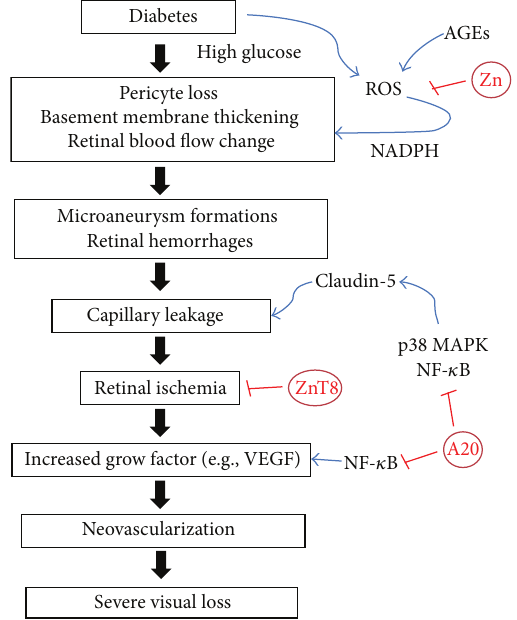
Figure 2: Proposed mechanism by which zinc protects from DR. Zinc protects DR by suppressing the pericyte apoptosis, capillary leakage, and